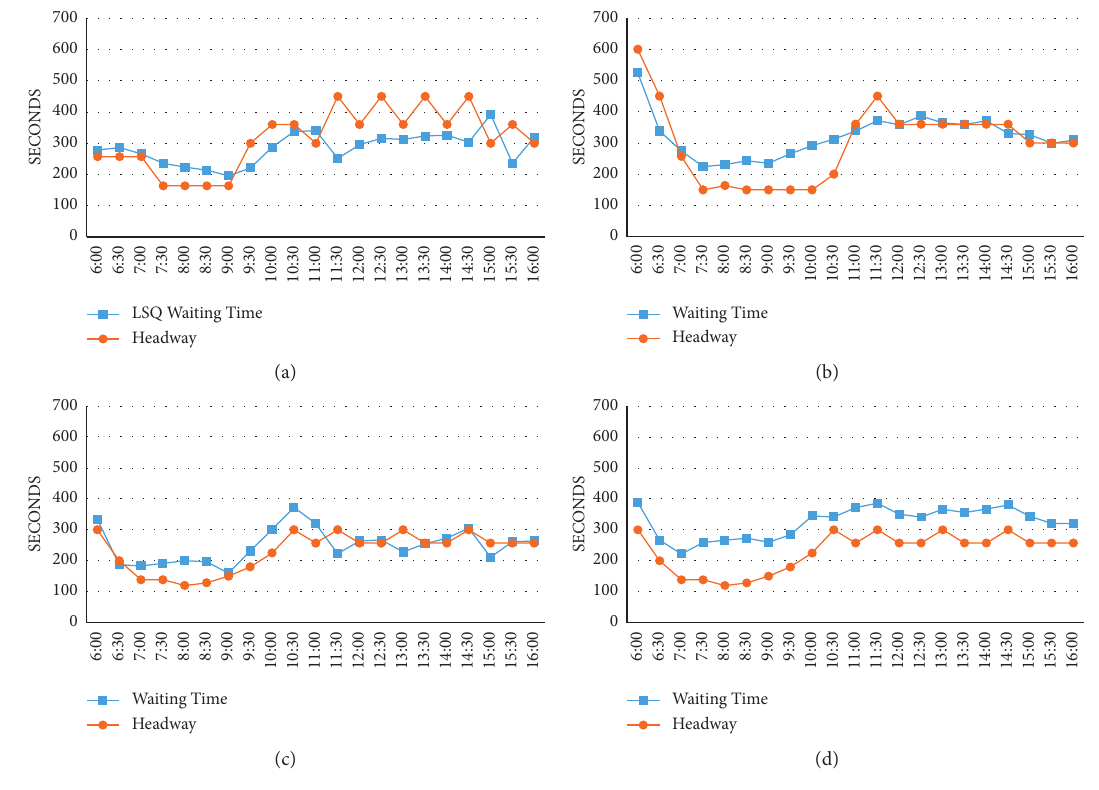
Figure 6: Average waiting time at transfer